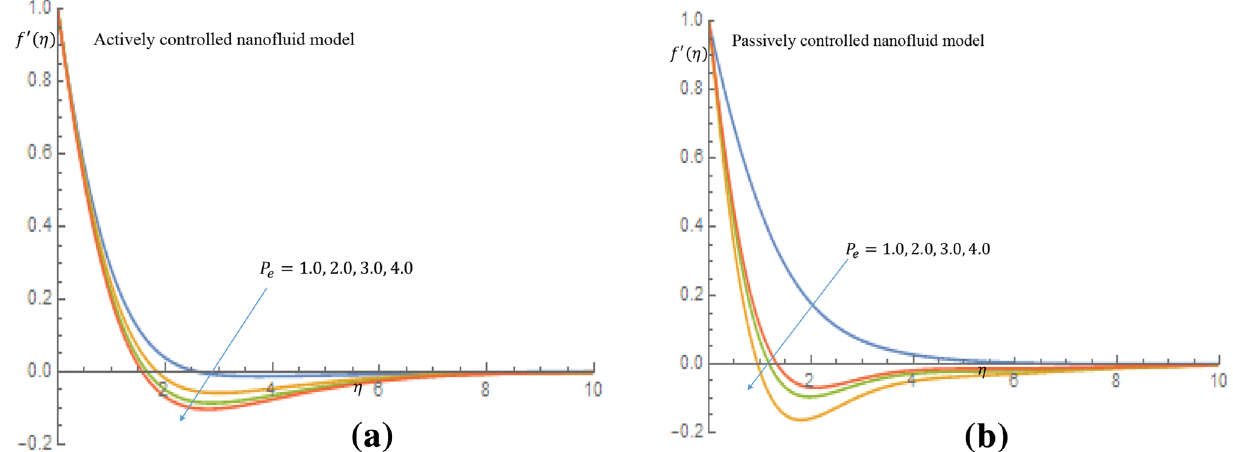
Figure 16. ( a ) Effect of P e on velocity profile when L e = 2.0 . ( b ) Effect of P e on velocity profile when L e = 2.0 .